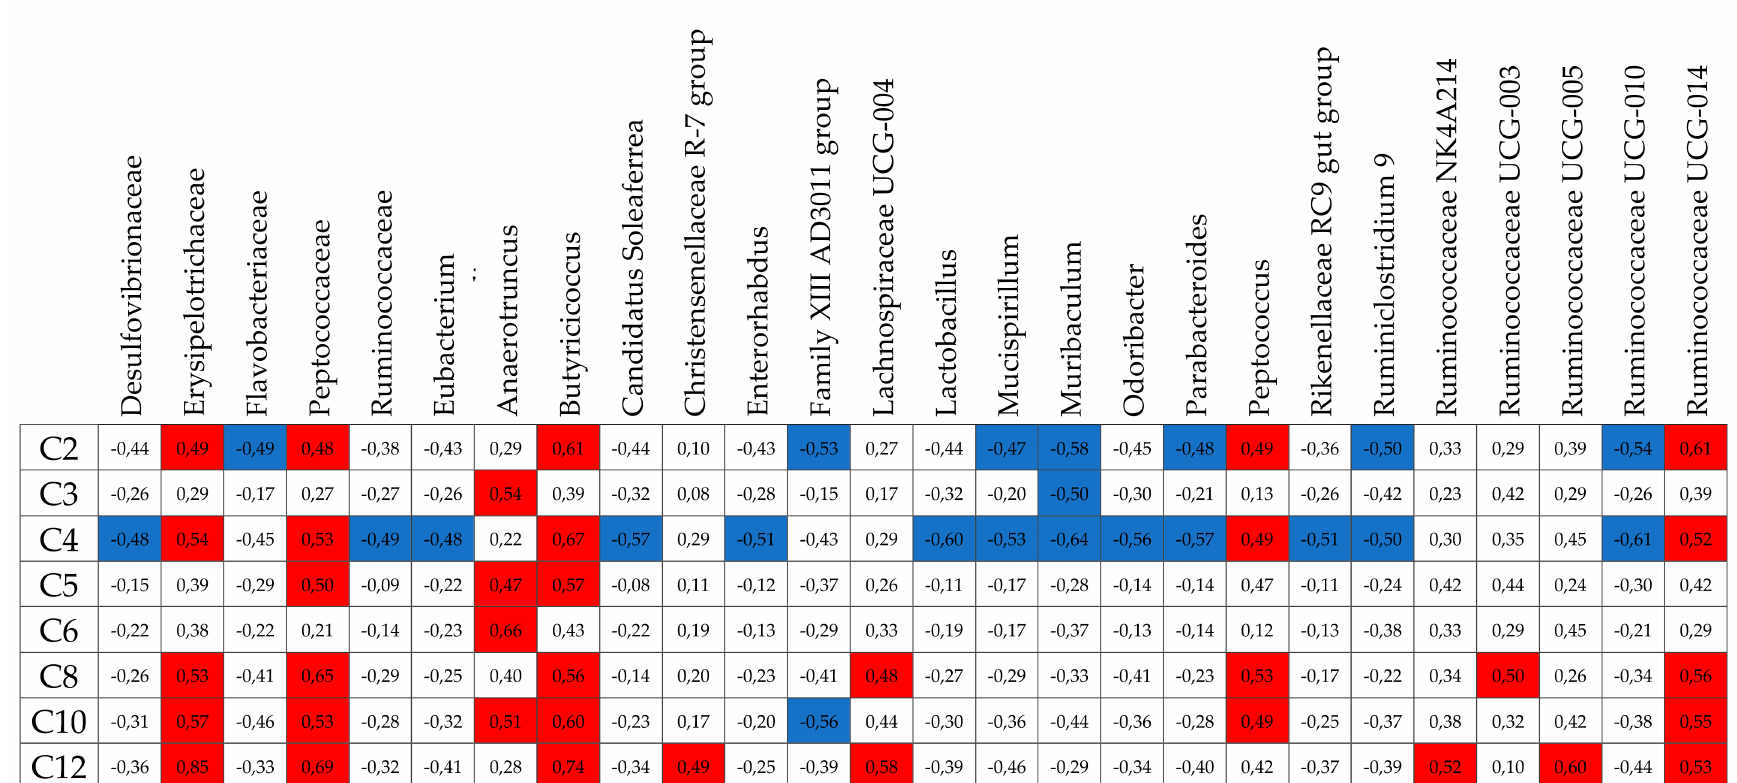
Figure 2. The occurrence of SCFA and MCFA correlates with fecal bacteria abundance. Correlation coefficients of FAs and bacteria are indicated in red colour for statistically significant positive correlations and in blue colour for statistically significant negative correlations; p <